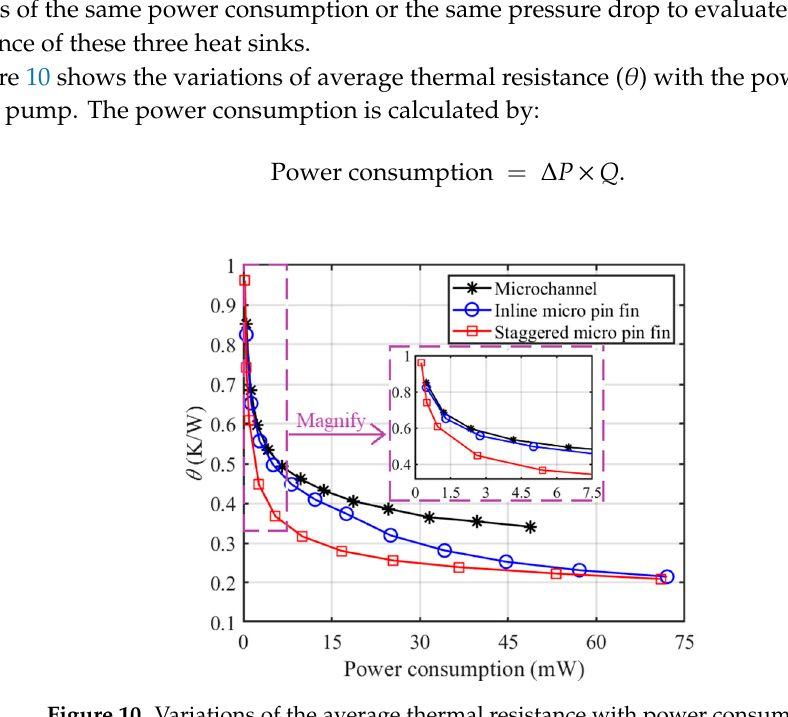
Figure 9. Variations of the pressure drop with the Reynolds number.